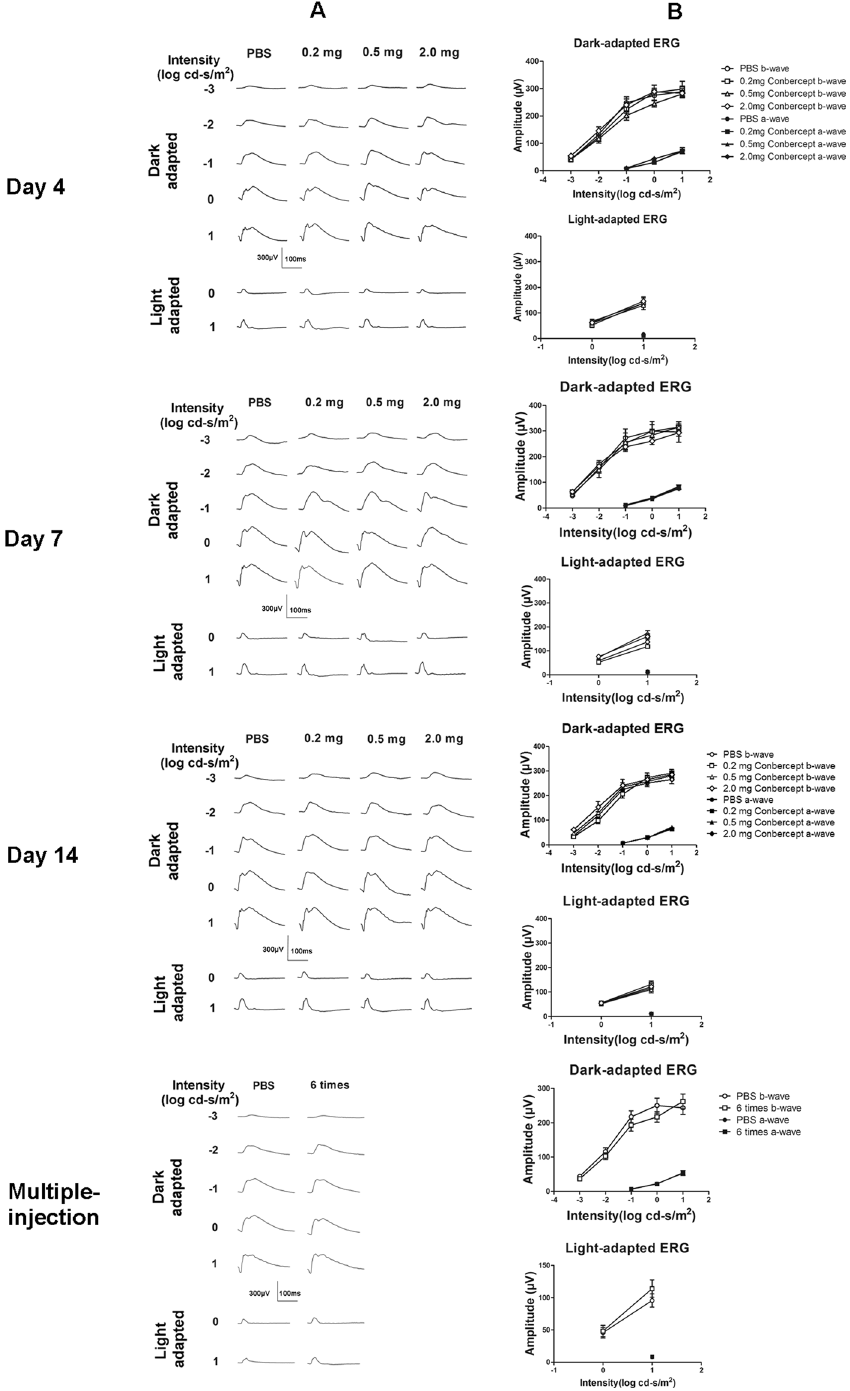
Figure 3. Dark- and light-adapted ERGs ( A ) and the amplitude vs . intensity profiles ( B ) obtained on the 4 th , 7 th , 14 th day after application of single intravitreal injections of 50 μ L PBS or 0.2, 0.5, 2.0 mg of conbercept and on the 7 th day after the 6 th multiple injections of 50 μ L PBS or 0.2 mg of conbercept. The amplitudes of a- and b-waves were not significantly different ( p > 0.05). The results were mean ± SEM (n =